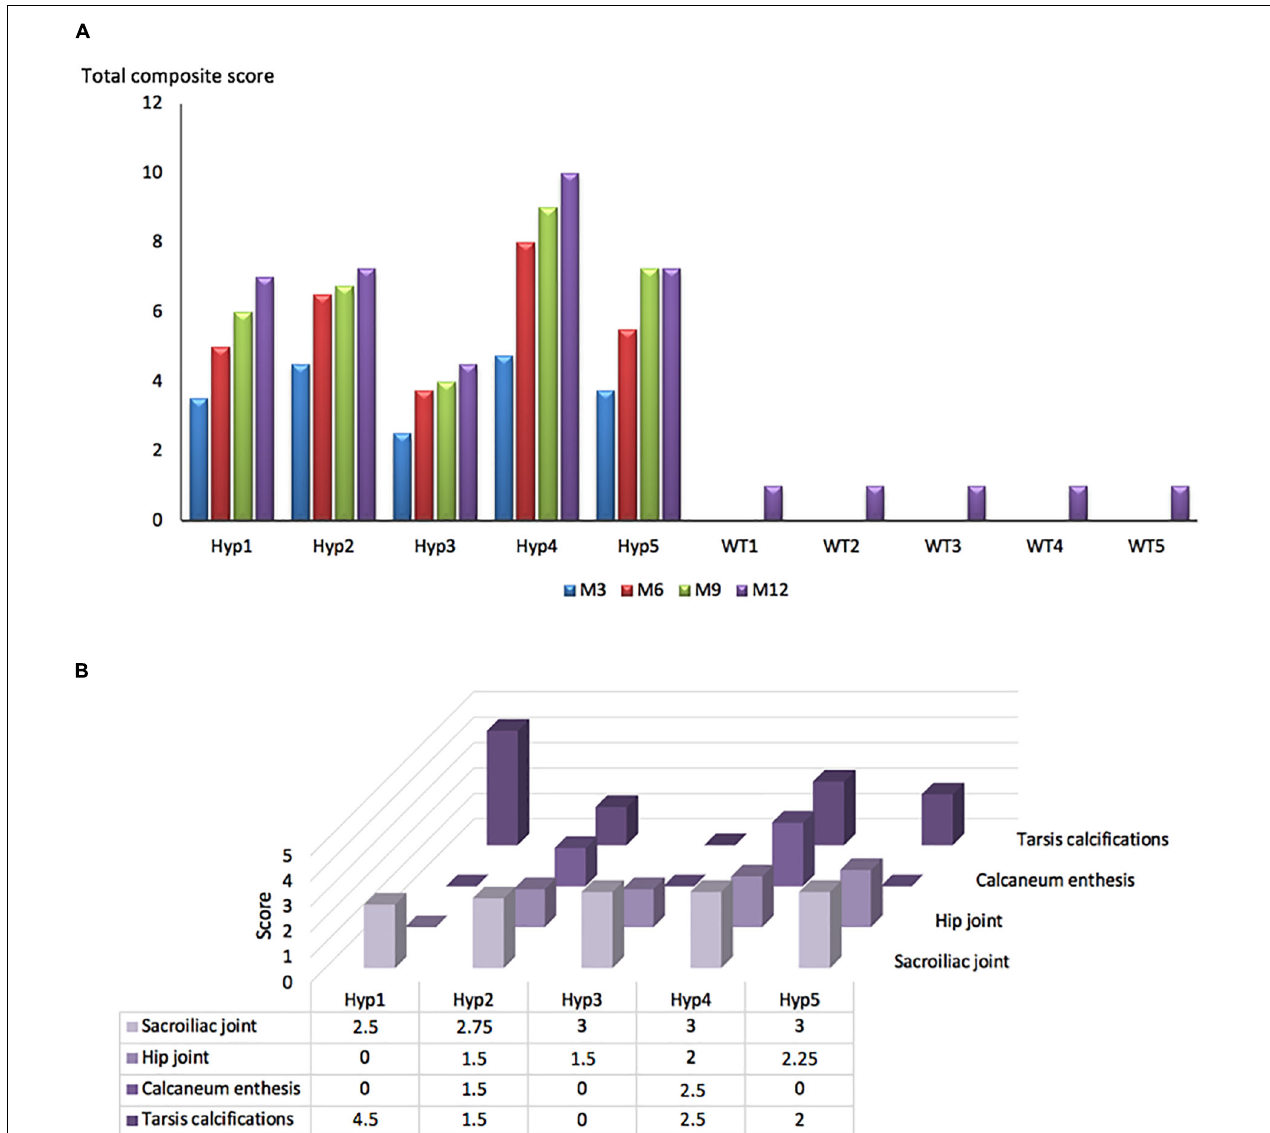
FIGURE 2 | Longitudinal changes in the total composite score in Hyp and WT mice. (A) A total composite score was established following the scoring grid ( Table 1 ) for each mouse at each time point (M3, 6, 9, 12). Enthesophytes, erosions and ossifications were observed in each Hyp mouse and no abnormalities were observed in controls. These lesions were already present at M3, the composite score increasing continuously over time. (B) Scores of enthesopathies, erosions, ossifications, and narrowing of joint established following the scoring grid ( Table 1 ) for each Hyp mouse at M12. No spinal enthesophytes were observed. The pattern of lesions differed between Hyp